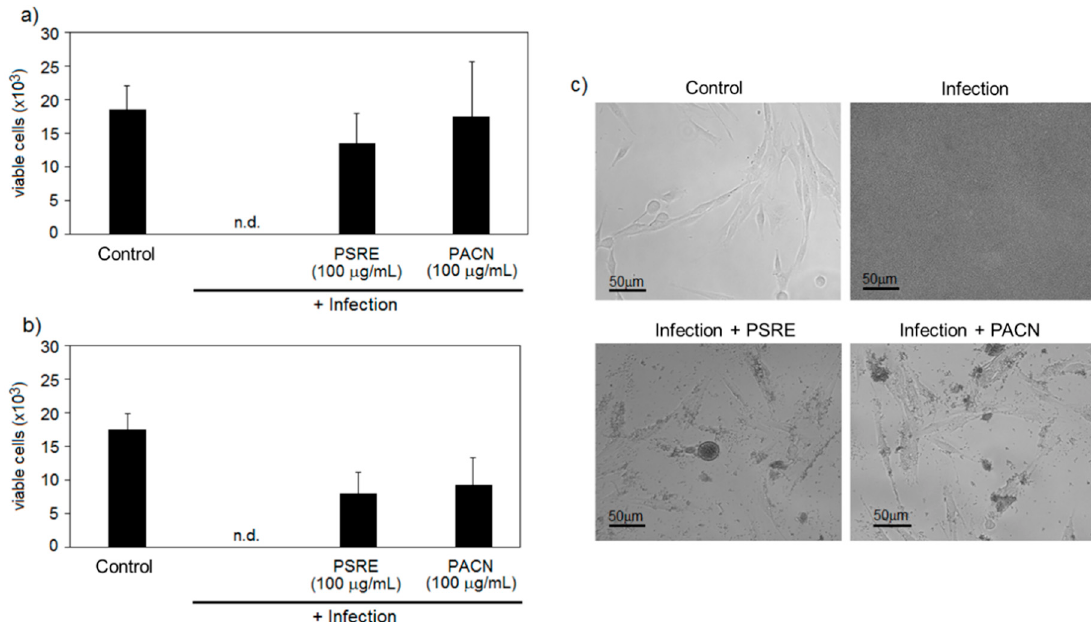
Figure 2. The effect of Pelargonium sidoides root extract (PSRE) and proanthocyanidins from PSRE (PACN) on human gingival fibroblast viability in co-culture “race for the surface” assay. Human gingival fibroblasts were infected with A. actinomycetemcomitans ( a ) or S. aureus ( b ); bars represent means and standard deviations of six experimental repeats. “Control” represents not infected cells, and “n.d.” means there were no detectable cells in the samples. In ( c ), there are representative images of human gingival fibroblasts with A. actinomycetemcomitans after 24 h of infection .